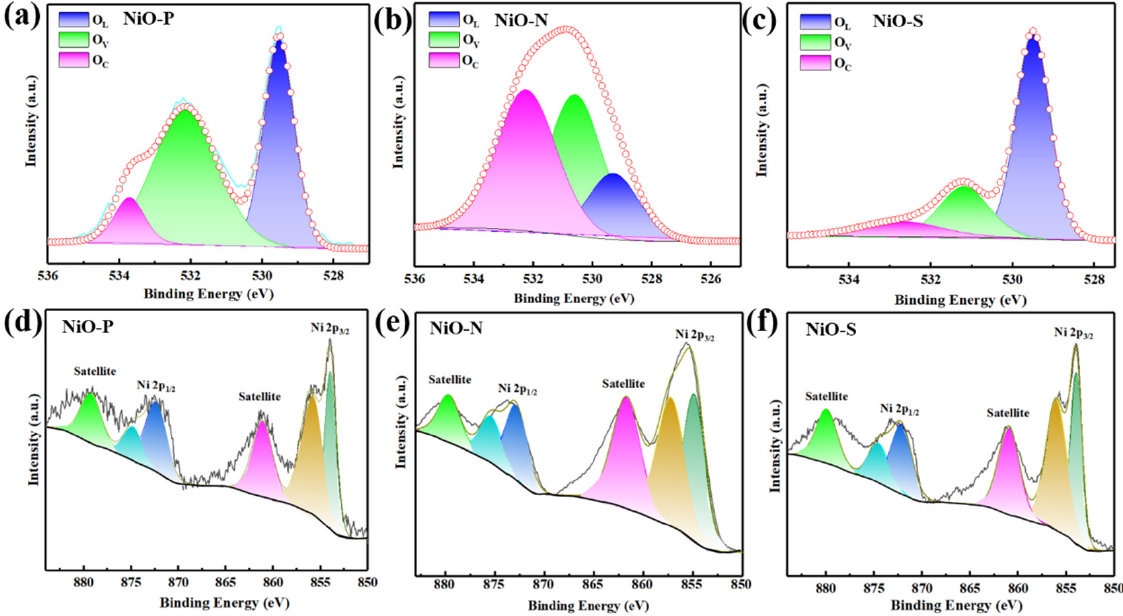
Figure 6. The O 1s XPS spectra of ( a ) NiO-P, ( b ) NiO-N, ( c ) NiO-S; the Ni 2p XPS spectra of ( d ) NiO-P, ( e ) NiO-N, ( f ) NiO-S. Table 1. The O 1s binding energy of NiO-P, NiO-N, and NiO-S. Sample